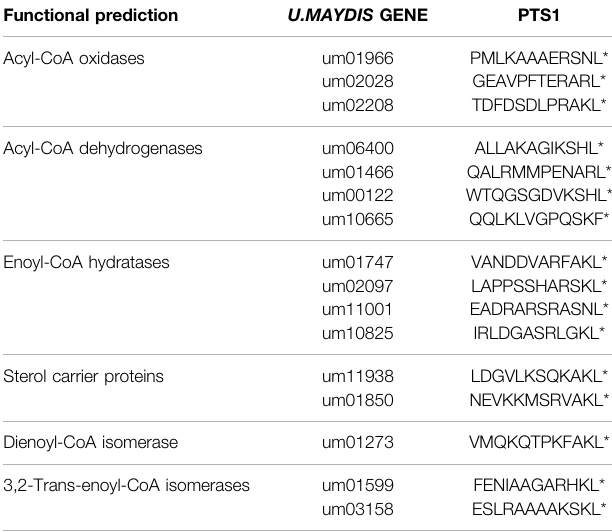
TABLE 1 | Candidates tested in the screen for Pex5a cargo.